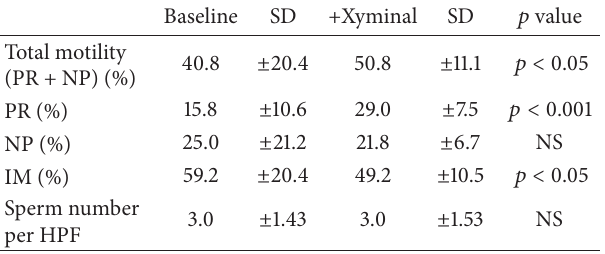
Table 3: Postcoital test results on sperm parameters.